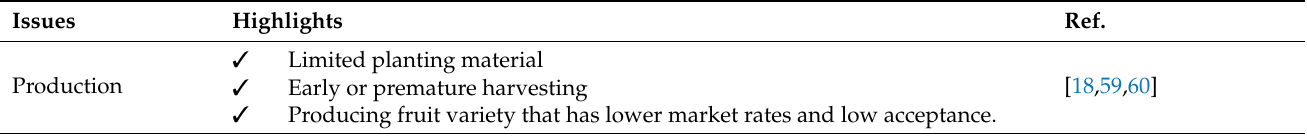
Table 4. Compiled production issues in kiwi value chain in Bageshwar District and their strategies and solutions